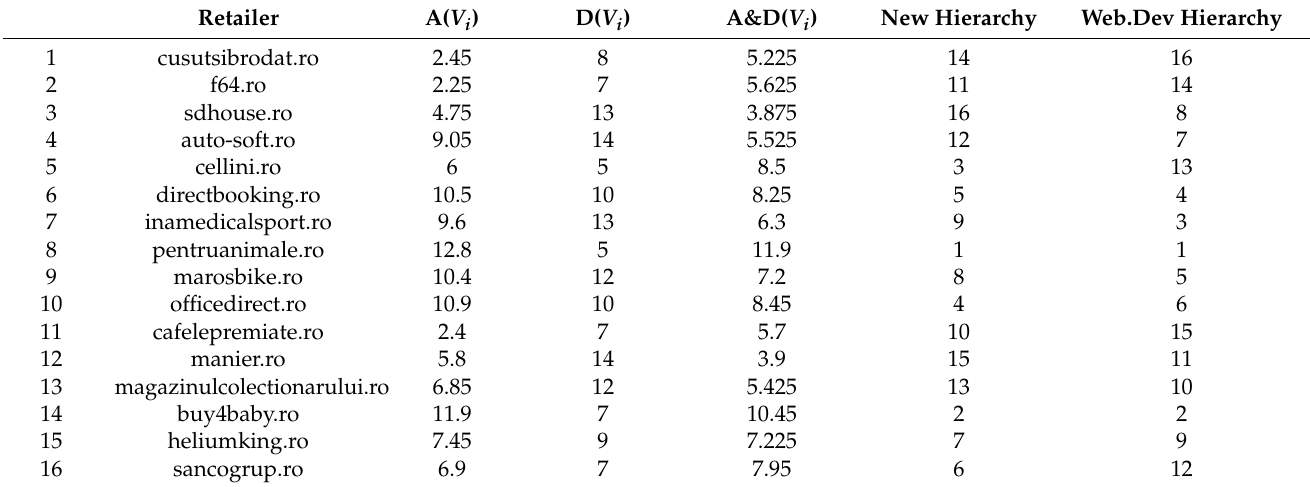
Table 4. Performance hierarchy by diameter method vs. initial web.dev hierarchy.